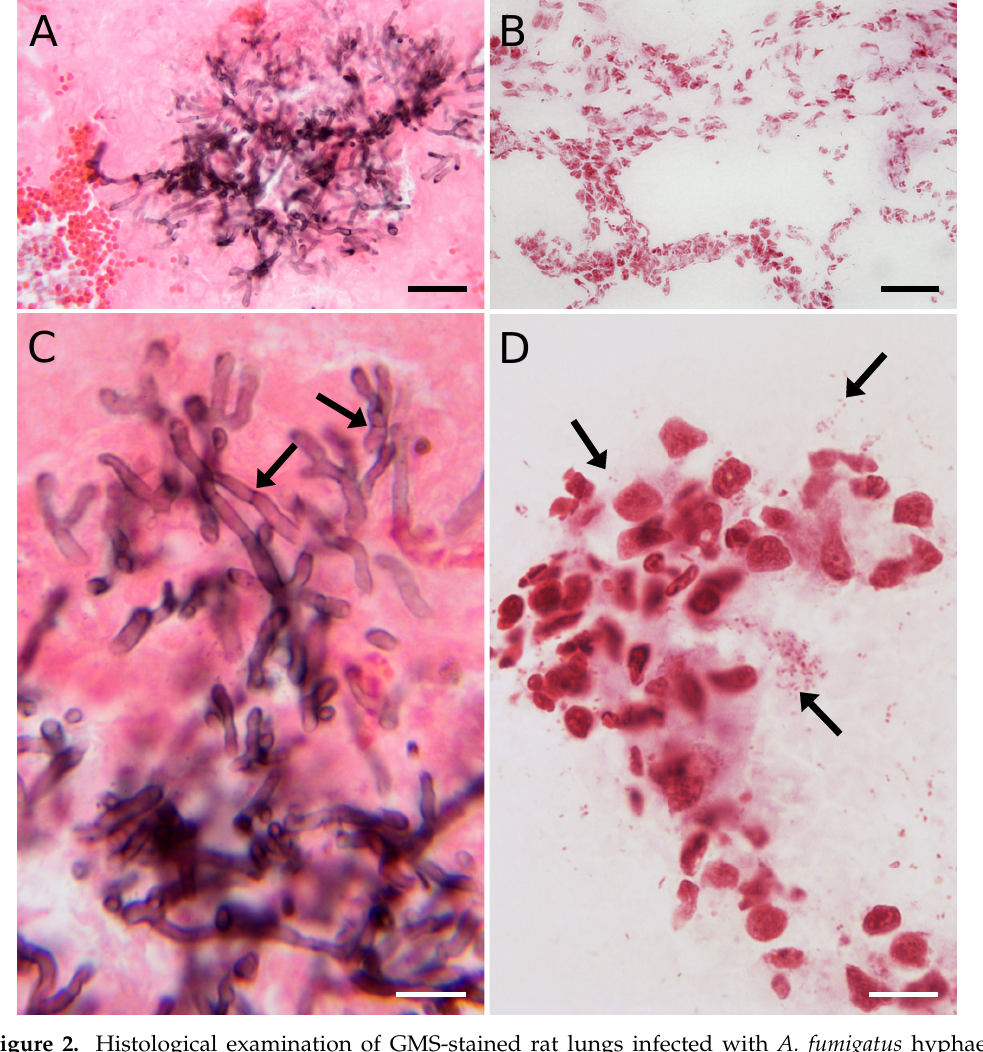
Figure 2. Histological examination of GMS-stained rat lungs infected with A. fumigatus hyphae ( A , C ) and Gram-stained P. aeruginosa cells ( B , D ). ( A ) Spreading of the fungus into the alveolar space. ( B ) Bacterial infection, 40 × objective. ( C ) Septate (arrows) and branching hyphae. ( D ) Individual bacterial cells (arrows), single or in distinct clusters imaged with a 100 × immersion objective. ( A ) A Leica built-in white balance compensation and ( D ) a custom white balance compensation were used. ( B , C ) The camera’s built-in white balance correction was used. Scale bars: 30µm ( A , B ) and 10µm ( C , D